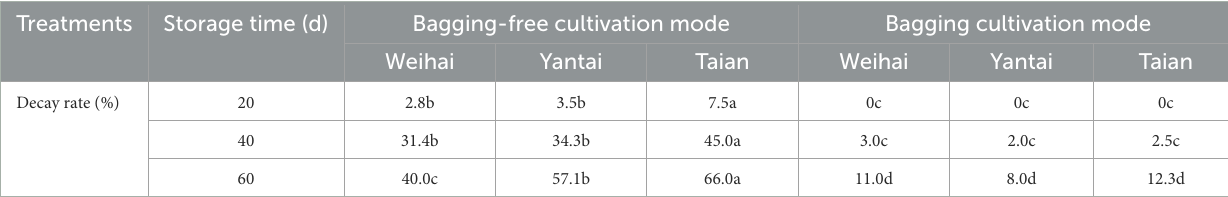
TABLE 2 Infection incidence of postharvest apple fruit. Treatments